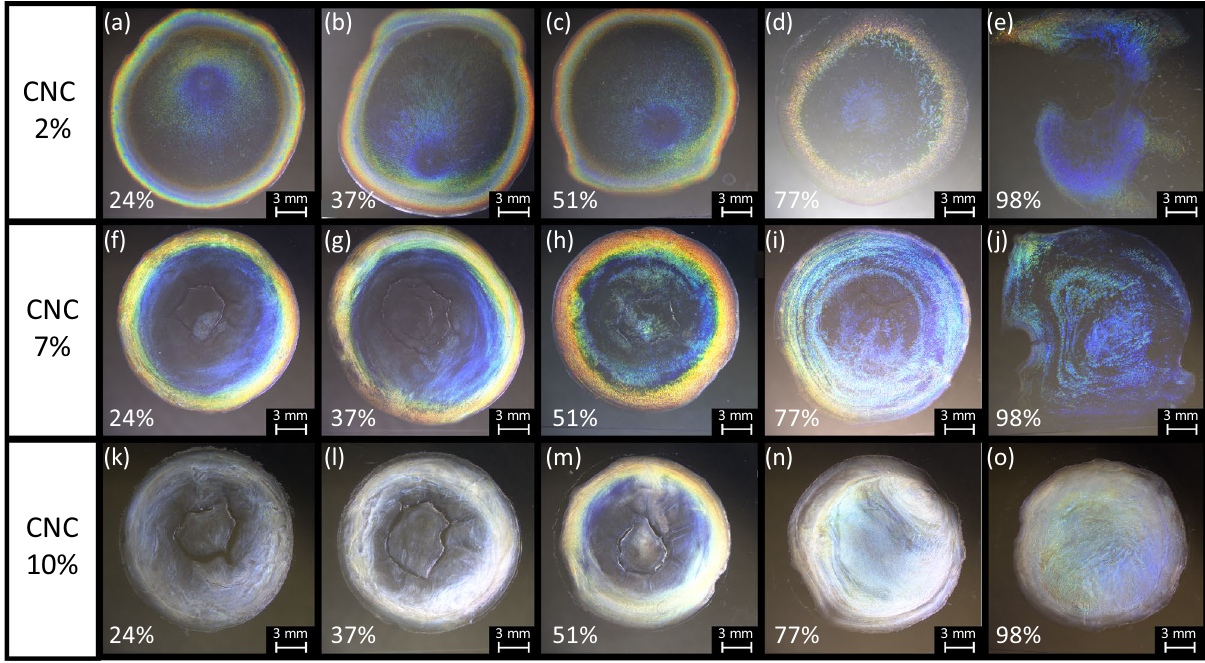
Figure 5. CNC films dried from droplets of ( a ) ‒ ( e ) 2%, ( f ) ‒ ( j ) 7%, and ( k ) ‒ ( o ) 10% CNC suspensions under increasing values of constant humidity (left to right). These images were acquired in reflection mode under white light without polarizers.